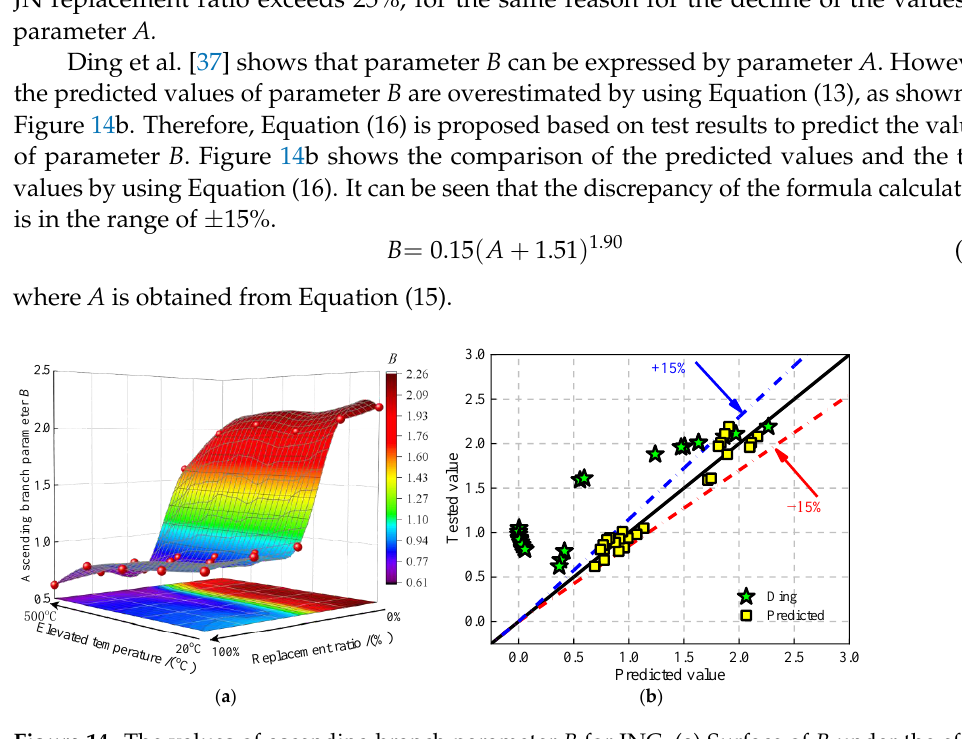
Figure 14. The values of ascending branch parameter B for JNC. ( a ) Surface of B under the effect of replacement ratios and the elevated temperature. ( b ) Comparison of the tested values and the predicted values